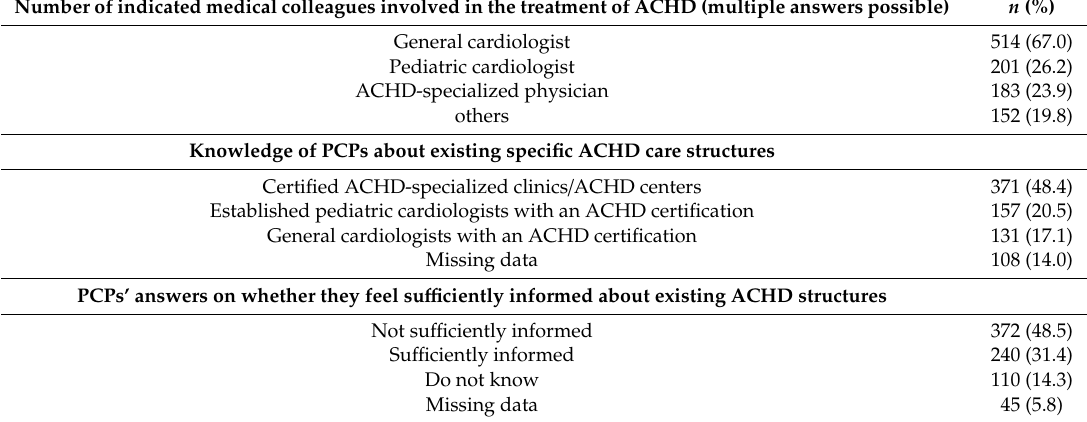
Table 3. Characteristics of the health care of adults with congenital heart disease. Multiple answers